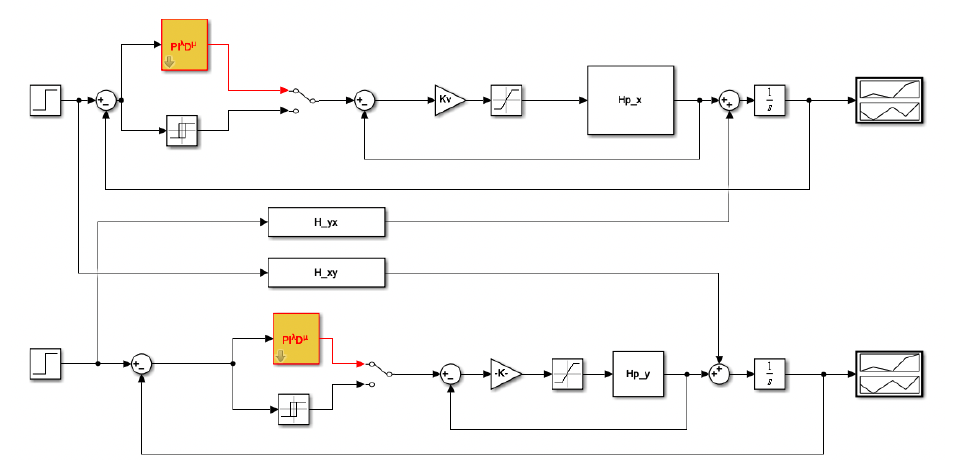
Figure 5. Closed-loop control structure for the two-axis positional mechatronic system having a P controller on the inner speed loop, and a FO – ID controller on the outer position loop, the switching element being used to commute between the controller (working mode) and the relay (design